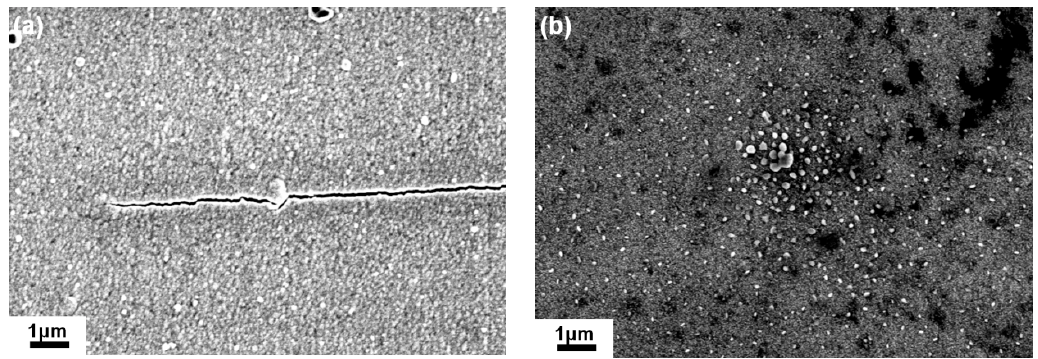
Figure 10. Surface morphologies of the ( a ) Ru 0.61 Al 0.39 and ( b ) Ru 0.46 Al 0.54 thin films after they were annealed in air at 800 °C for 30 min.